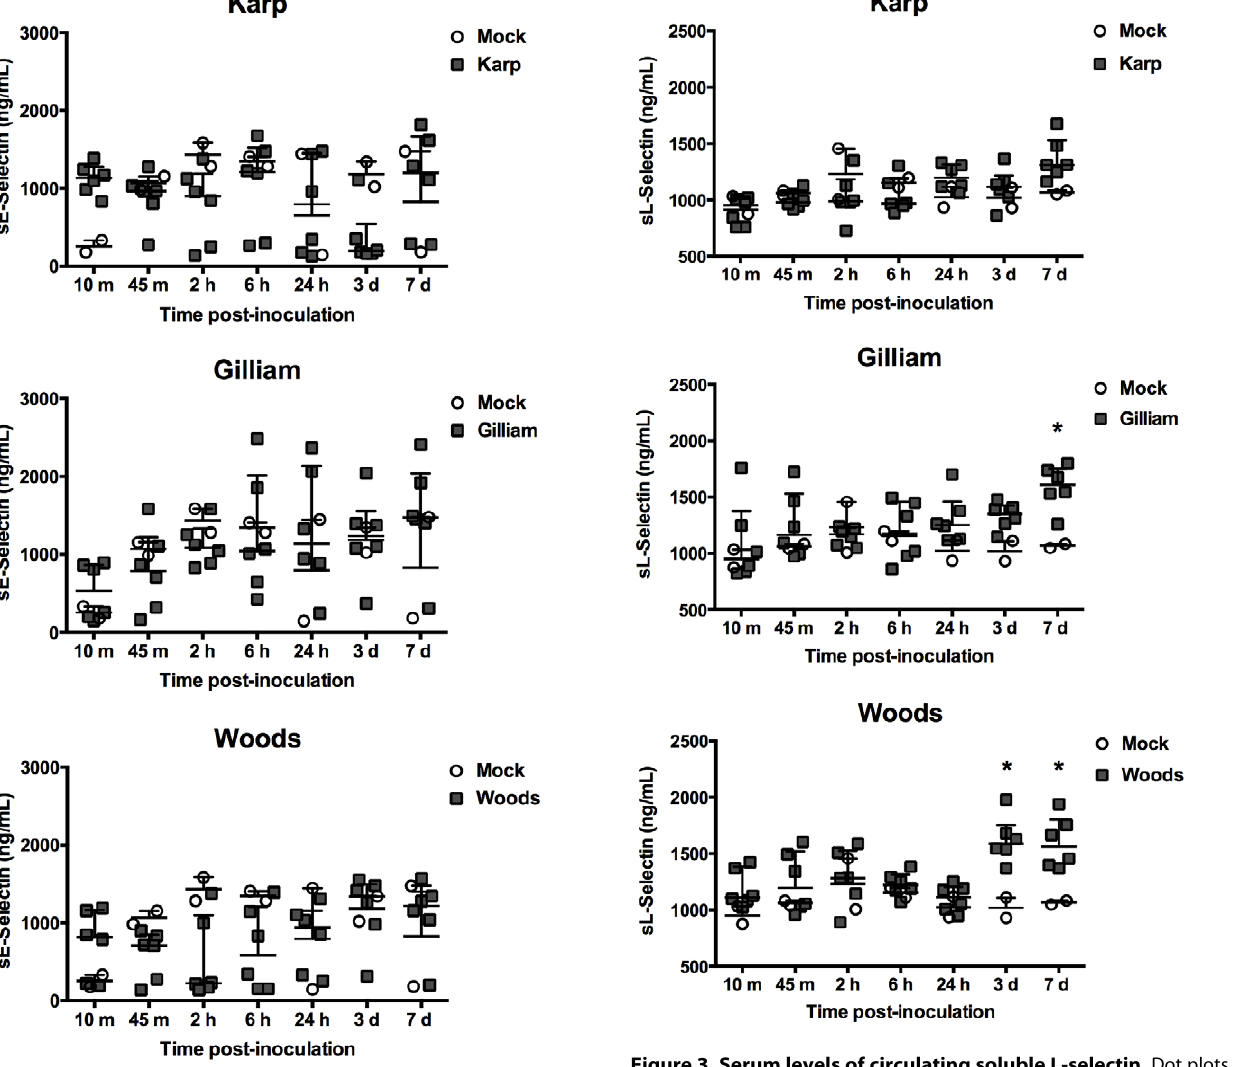
Figure 3. Serum levels of circulating soluble L-selectin. Dot plots demonstrate sL-selectin levels in inoculated mouse sera. (Mock inoculation; n=2 per time point, O. tsutsugamushi inoculation; n=6 per time point). Bars indicate median and error bars represent interquartile range. The asterisks indicate significant differences ( P ,